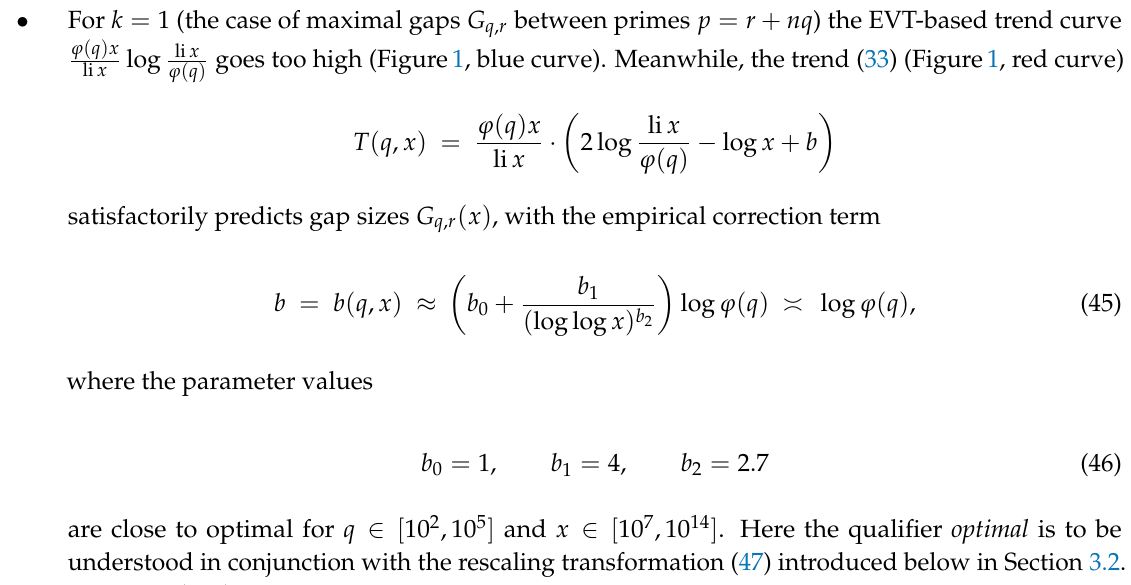
ϕ 2 ( q ) log 3 p 2